Question: Does the plotted quantity increase or decrease?
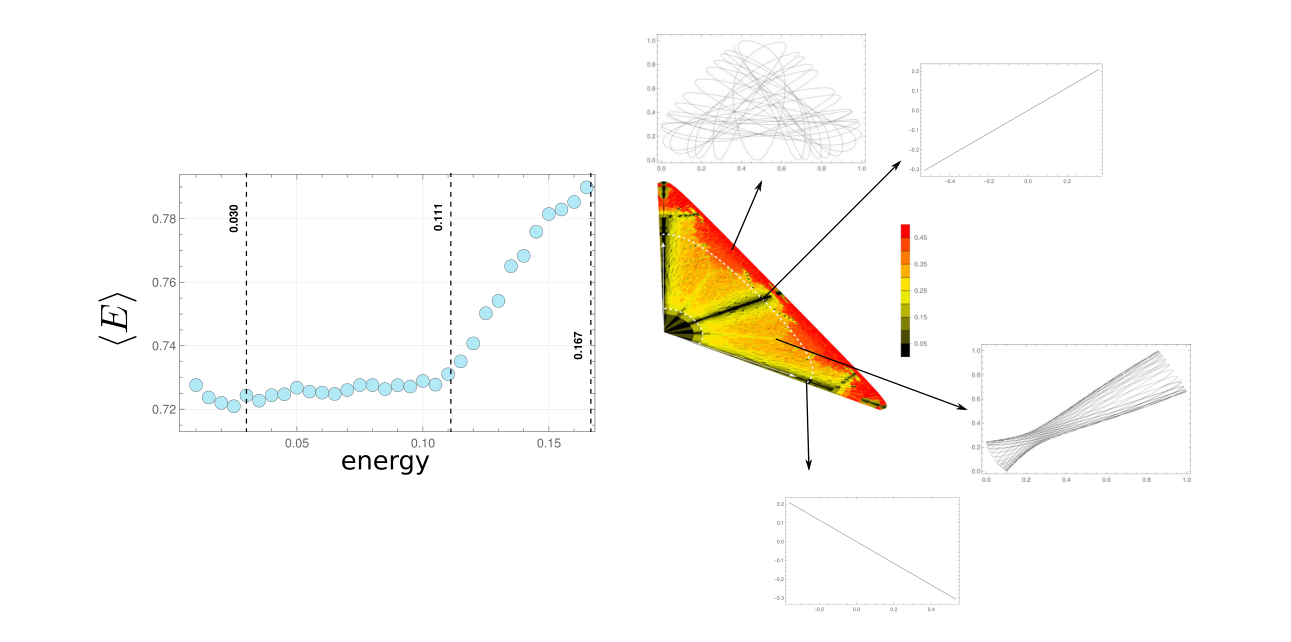
Answer: increasing